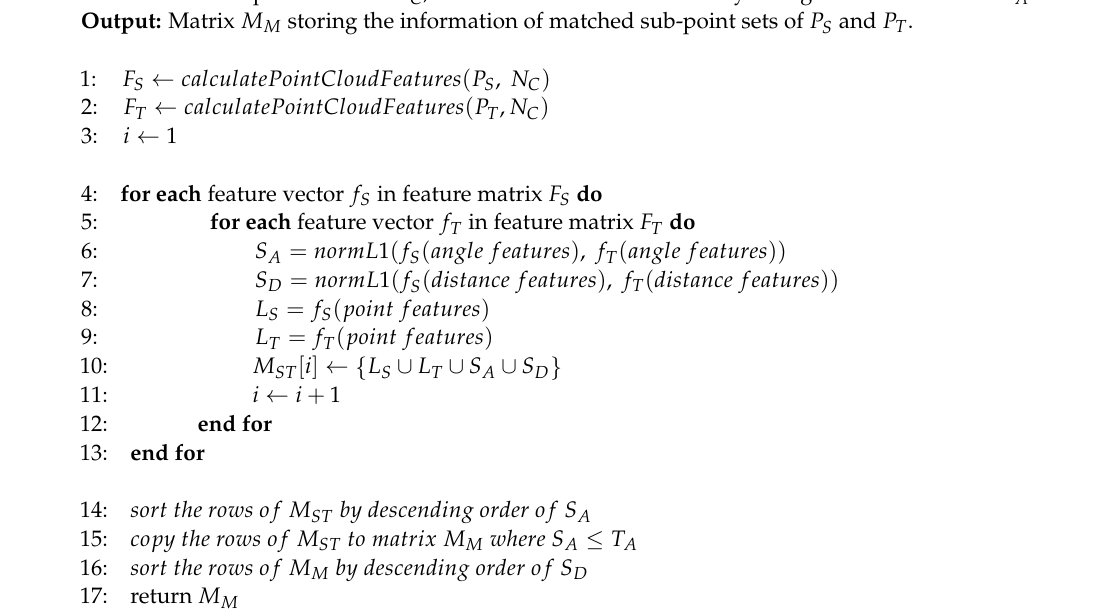
Algorithm 2. Selection of the subpoint sets from the source and target point clouds for matching. Input: Source and target point clouds are P S and P T , number of the sub-points that are going to be selected from the point cloud is N C , distance threshold for similarity of angle based features is T A